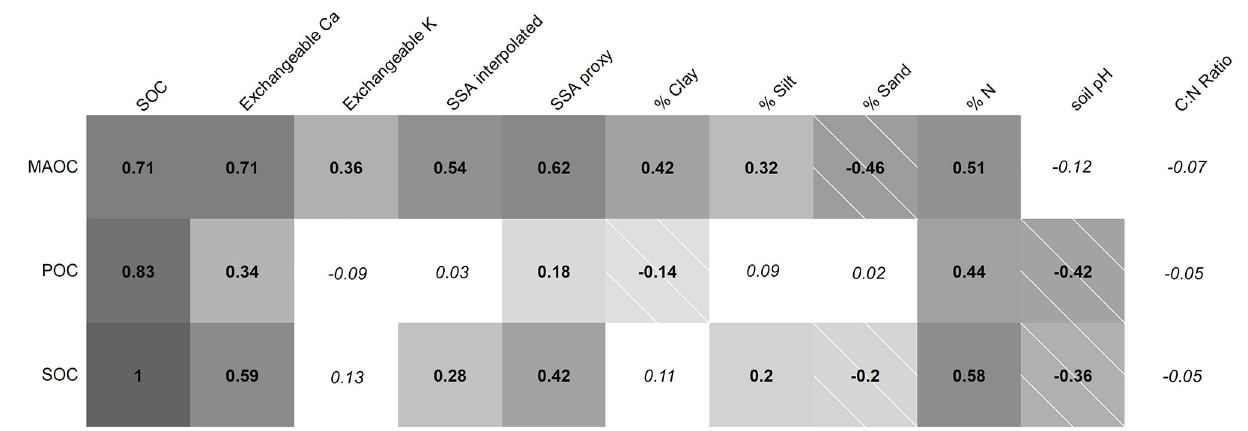
FIGURE 4 | Correlation matrix of soil characteristics measured on the 216 measured samples included in the models and for discussion. Numbers in each cell are the Pearson correlation coefficient between the two variables. Shade intensity is representative of the strength of the correlation, and hashed boxes represent negative correlations. Relationships in white cells with italicized correlation coefficients were not statistically significant ( p > 0.05). SSA interpolated values are specific surface area values calculated using the Brunauer, Emmet, and Teller (BET) theory and values interpolated using a best fit line. Mineral associated organic carbon (MAOC) is the C concentration in the < 50 µ m fraction, while Particulate organic carbon (POC) is the C concentration in the > 50 µ m fraction. Soil organic carbon (SOC) is the total organic carbon present in the soil sample. Specific surface area proxy (SSA p ; roxy ) is the mineral surface area as measured using the moisture loss method as in Equation